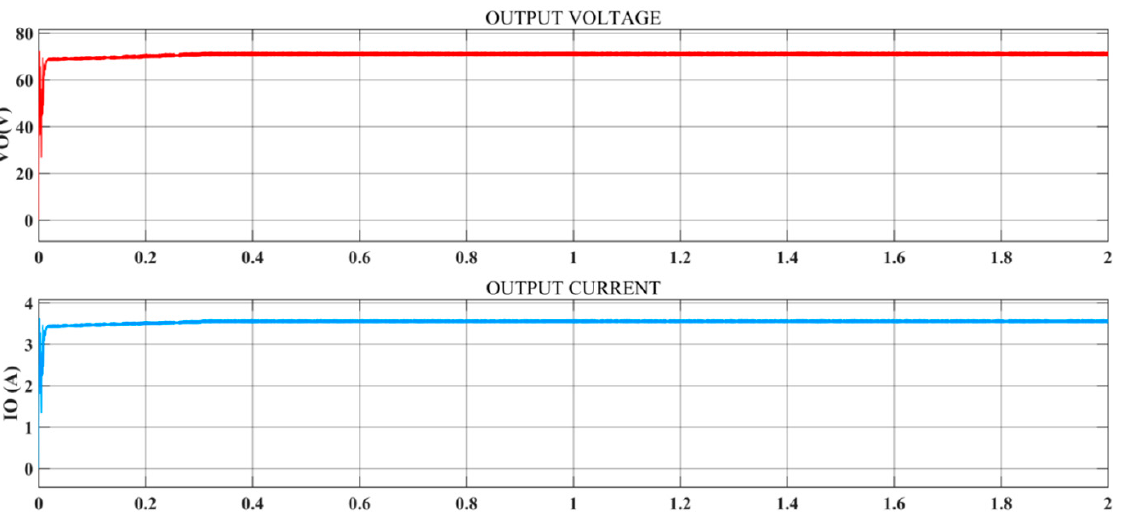
Table 4. Calculation of efficiency of the converter through different losses SL. NO